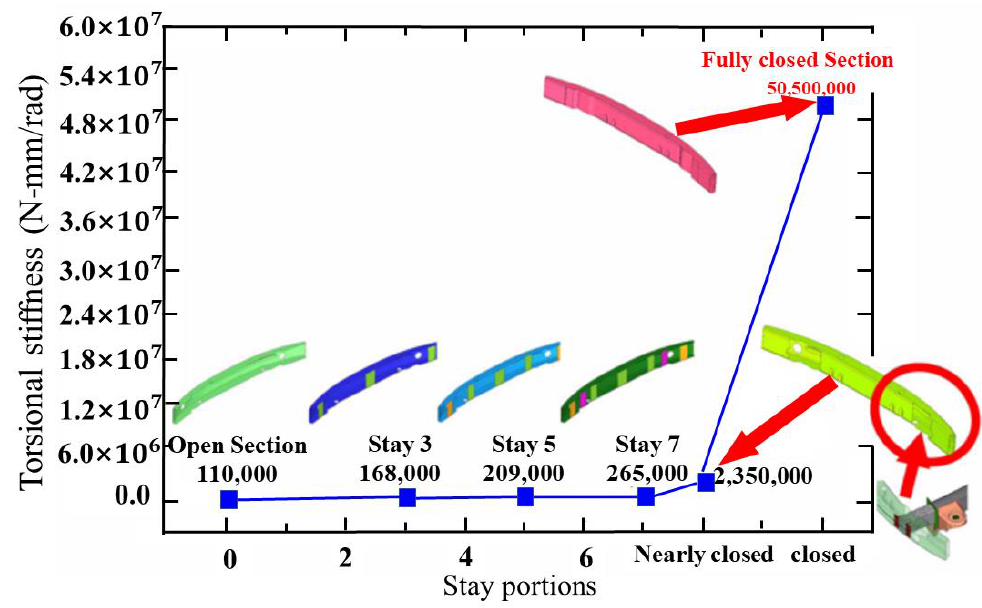
Figure 15. Effect of stay portions on torsional stiffness [42].